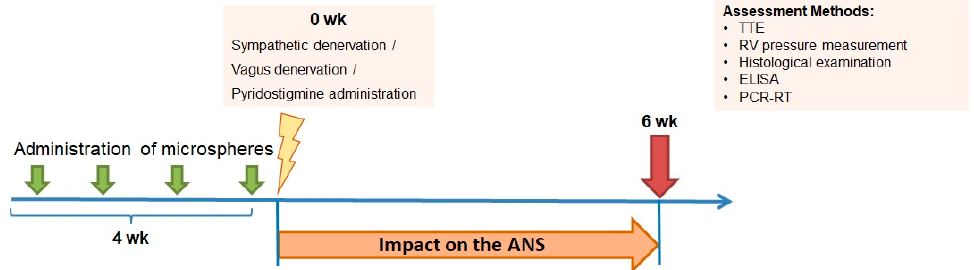
Figure 1. Study design. After induction of CTEPH by intravenous administration (four times, weekly) of alginate microspheres, the animals were randomized into 6 groups, including intact animals, CTEPH, CTEPH + SD, CTEPH + VD, and CTEPH + PS. CTEPH—chronic thromboembolic pulmonary hypertension, CTEPH + SD—CTEPH + sympathetic denervation, CTEPH + VD—CTEPH + vagus denervation, CTEPH + PS—CTEPH + pyridostigmine. Six weeks after surgery, the end-points were analyzed, including echocardiography, invasive hemodynamic measurements,